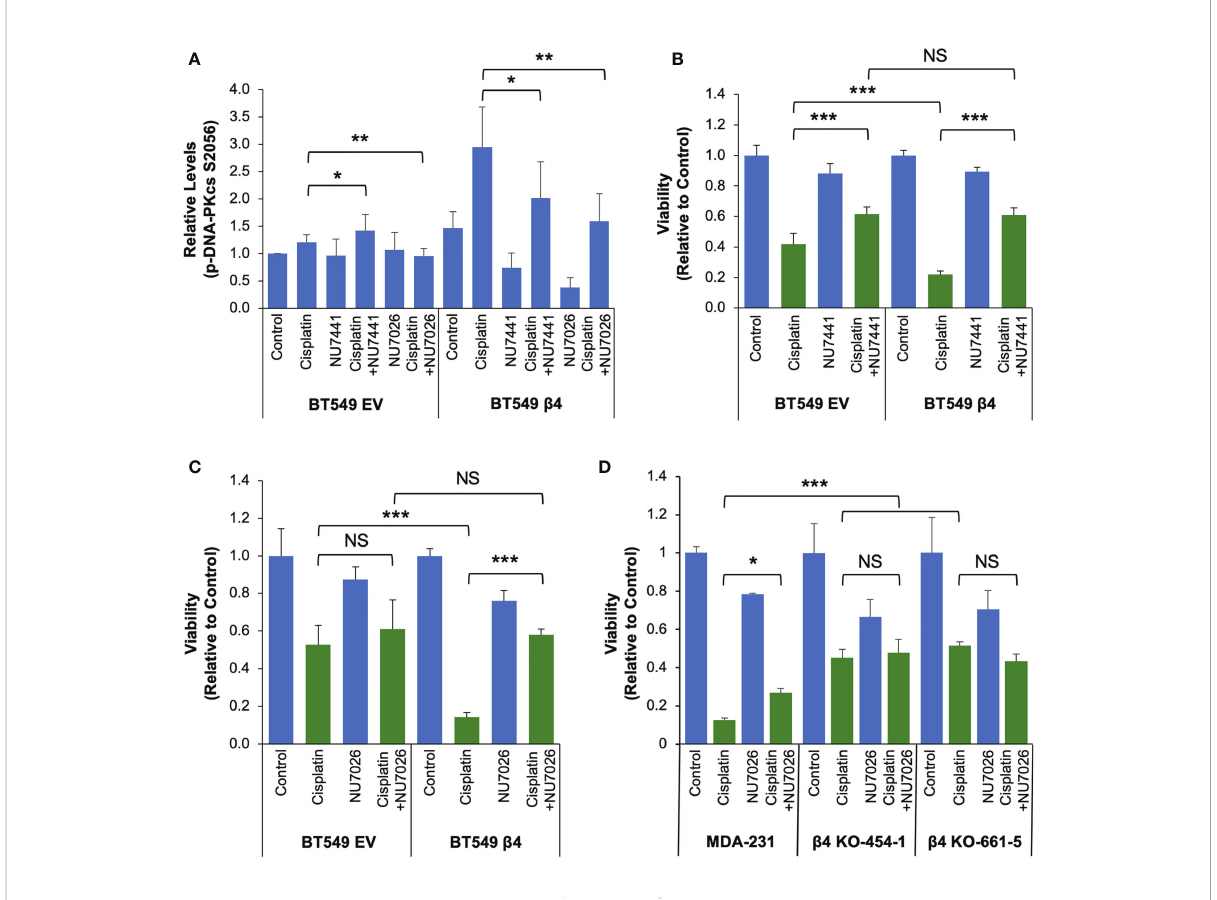
FIGURE 7 DNA-PK is critical for integrin a 6 b 4 signaling-mediated cisplatin sensitivity. (A-C) BT549 cells (EV and b 4) were treated with vehicle (Control), 1µM cisplatin and/or DNA-PK inhibitor (0.1 µM NU7441 or 1µM NU7026, as noted) for 6 days. The phosphorylation of DNA-PKcs S2056 was assessed by immunoblotting, quanti fi ed, and reported as relative changes to BT549-EV control (A) . (D) MDA-MB-231 cells and the integrin b 4 knock out cells with one of two distinct gRNAs (clones 454-1 and 661-5) were treated with vehicle (Control), 1µM cisplatin and/or 1µM NU7026 as noted for 6 days. Cell viability was assessed by MTT assays for the effect of NU7441 (B) and NU7026 (C, D) for indicated cells. Data are representative of at least 3 separate experiments. *p < 0.05, **p < 0.005. ***p < 0.0005. NS, Not Signi fi